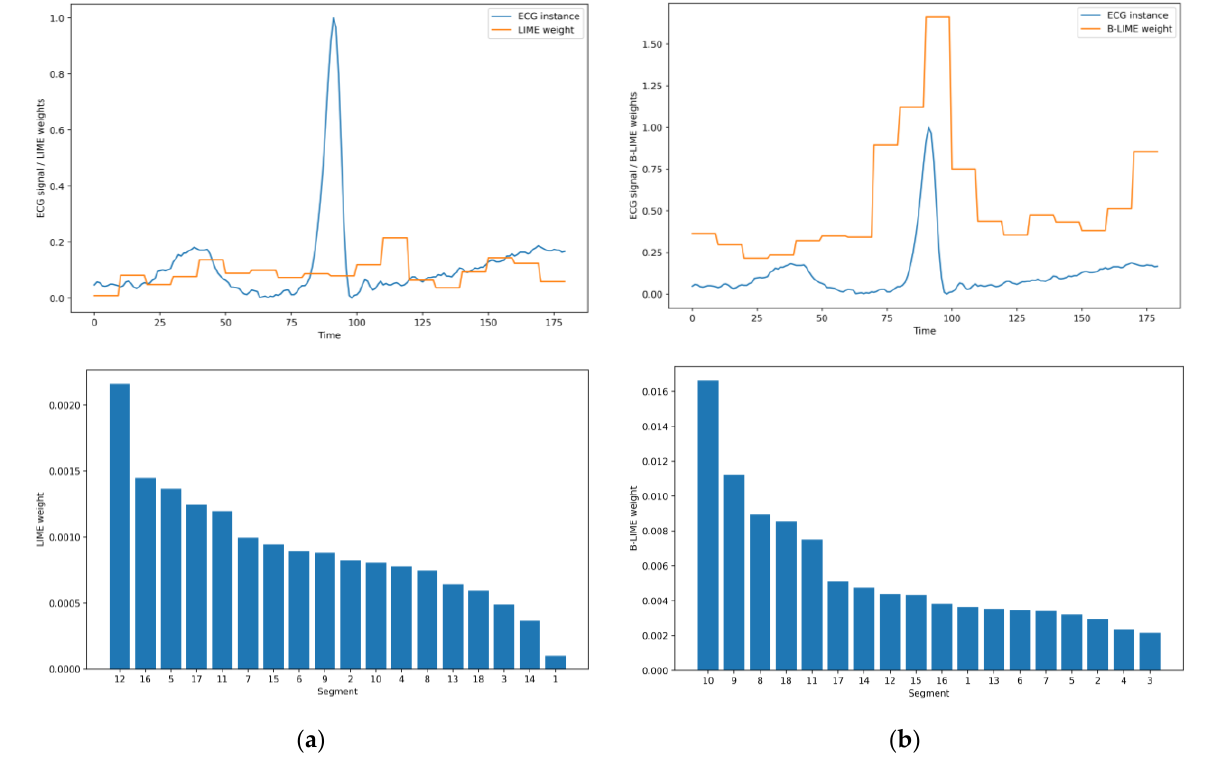
Figure 7. Comparison between LIME and B-LIME explanation generation for a heartbeat instance. ( a ) LIME explanation. ( b ) B-LIME explanation.